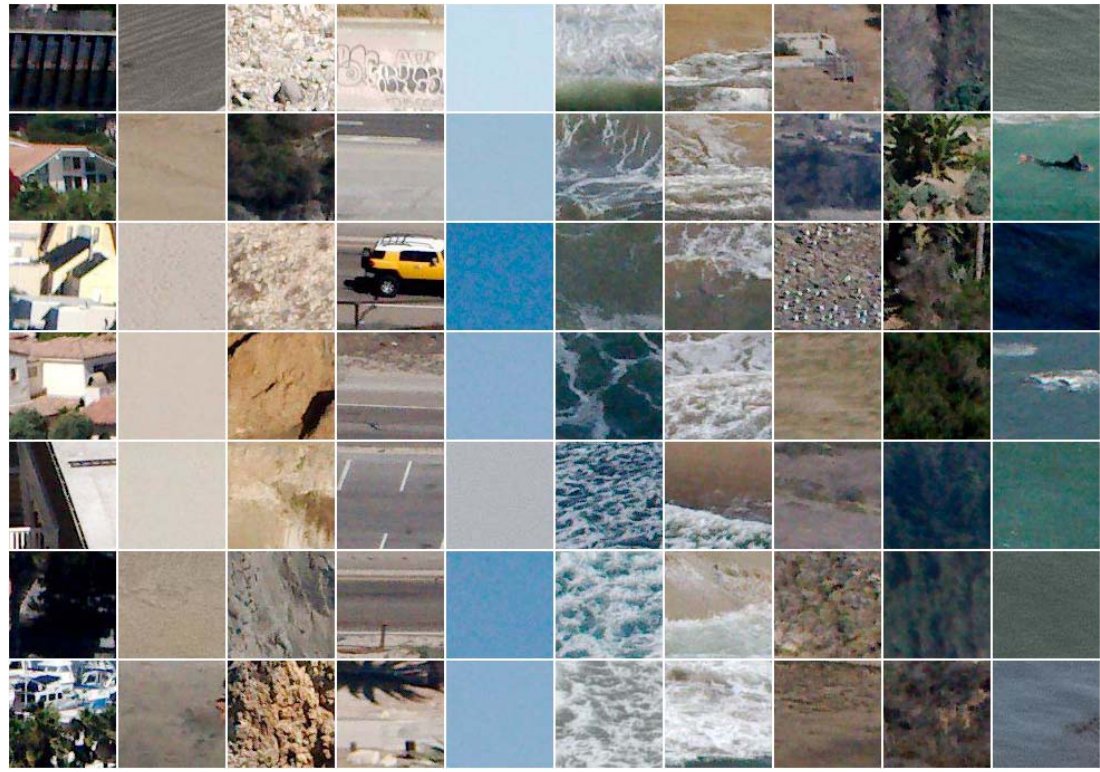
Figure 7. Example tiles from CCRP dataset. Classes, in columns, from left to right, are buildings/anthropogenic, beach, cliff, road, sky, surf/foam, swash, other natural terrain, vegetation, and water.